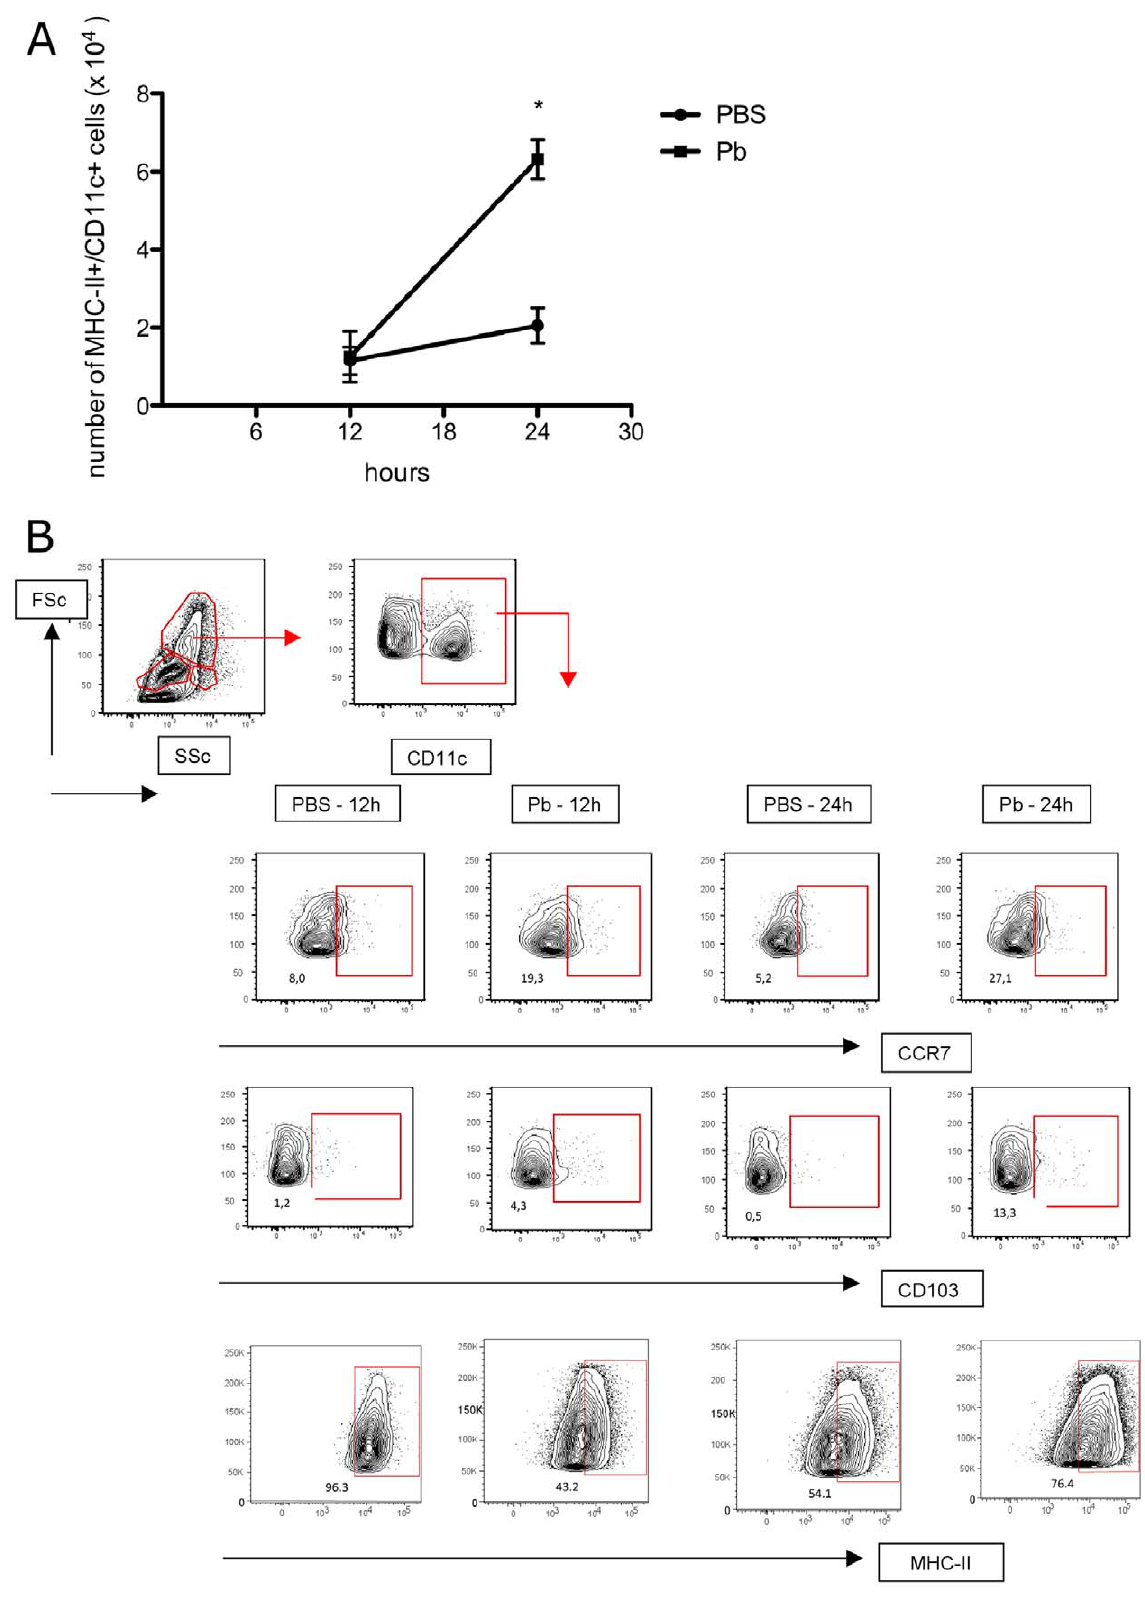
Figure 1. Migration and phenotype of DC in lung during Pb infection. A- At several time points after Pb infection, the absolute numbers of DC (MHC-II + /CD11c + ) were determined in the lung. Error bars represent the SEM. B-Phenotype of lung DC after Pb infection, the gate represent positive cells, determined by FMO, as described in the M&M. This figure is representative of 3 different experiments. The numbers represent the percentage of positive cells. The experiment was performed at least 3 times. *p , 0.05 when compared with PBS treatment. doi:10.1371/journal.pone.0019690.g001 PLoS ONE | www.plosone.org